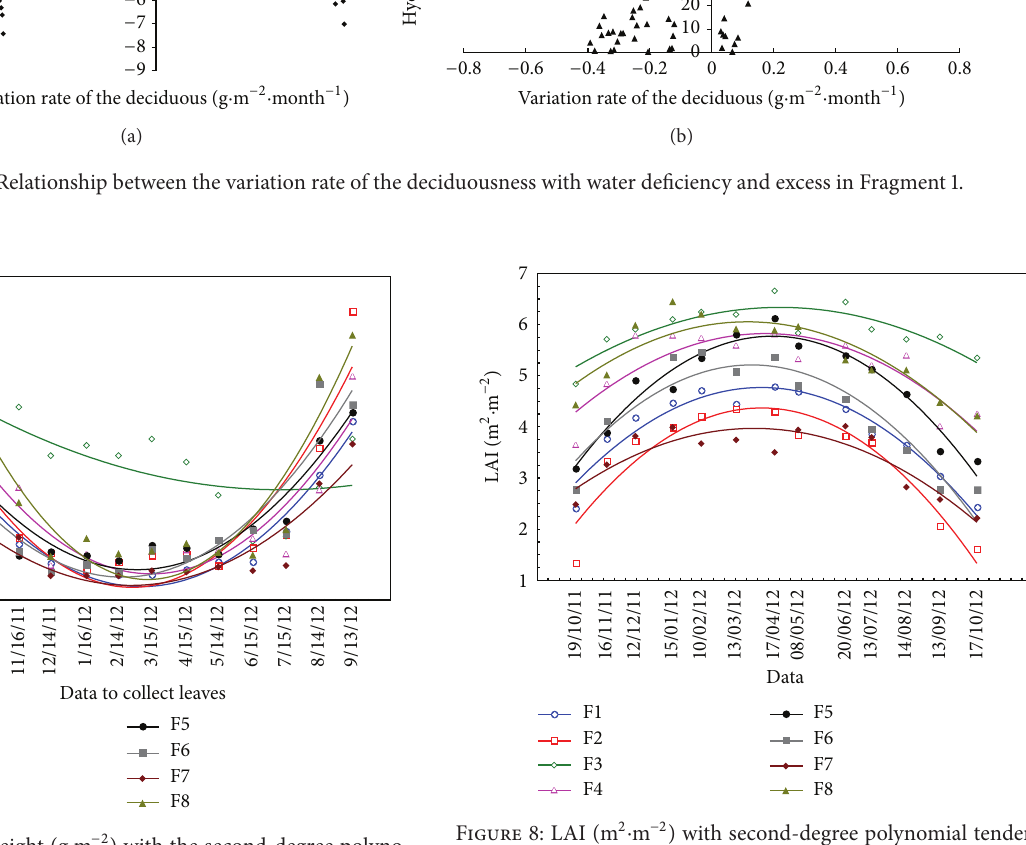
Figure 7: Dry leaf weight (g ⋅ m −2 ) with the second-degree polyno- mial tendency for each fragment.